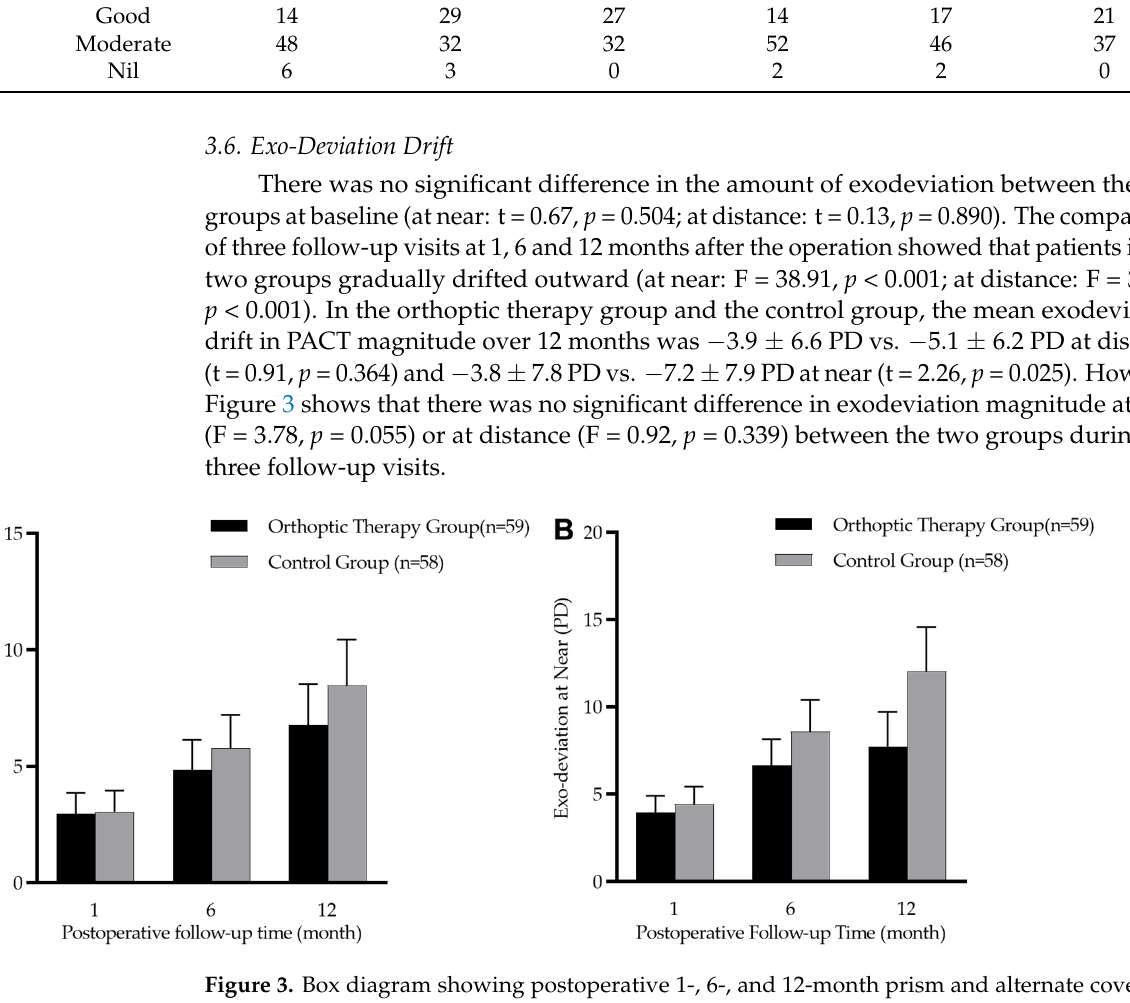
Figure 3. Box diagram showing postoperative 1-, 6-, and 12-month prism and alternate cover test (PACT) magnitudes in the orthoptic therapy group (n = 59) and the control group (n = 58). ( A ): distance deviation; ( B ): near deviation.